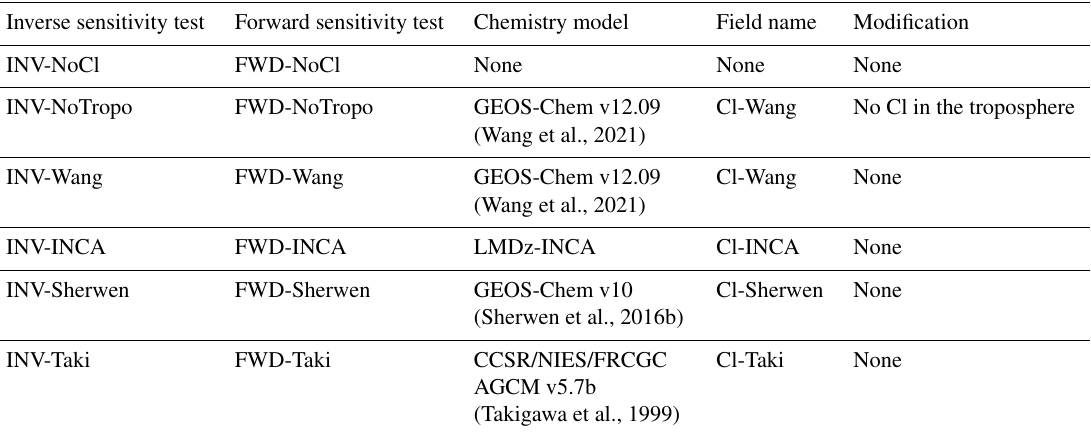
Table 3. Nomenclature and description of the sensitivity tests performed in this study. The INV- ∗ simulations refer to both the variational inversion performed with the system of Thanwerdas et al. (2022) and to the final forward simulation of this inversion process with the associated optimized fluxes and source signatures. For each test, the model used to simulate Cl concentrations is given. Forward sensitivity tests (FWD- ∗ ) have also been run with identical optimized fluxes and source signatures based on the INV-Wang outputs. Note that INV-Wang and FWD-Wang are